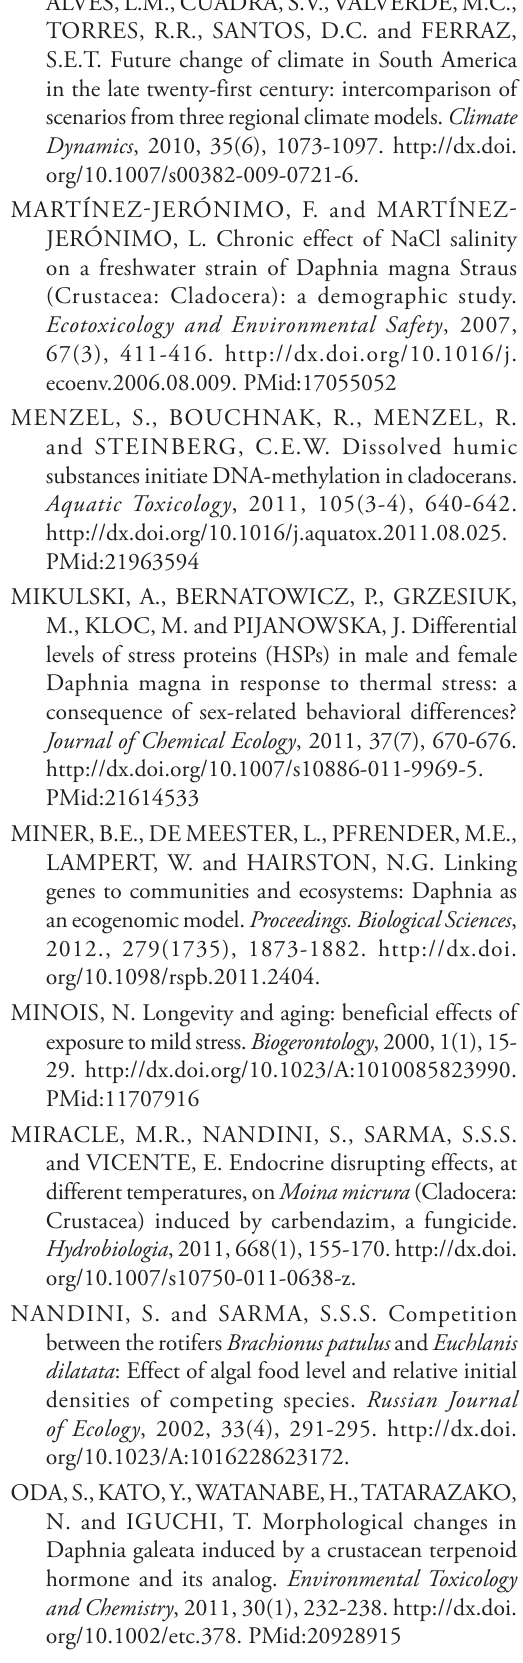
table approach. Journal of Plankton Research ,